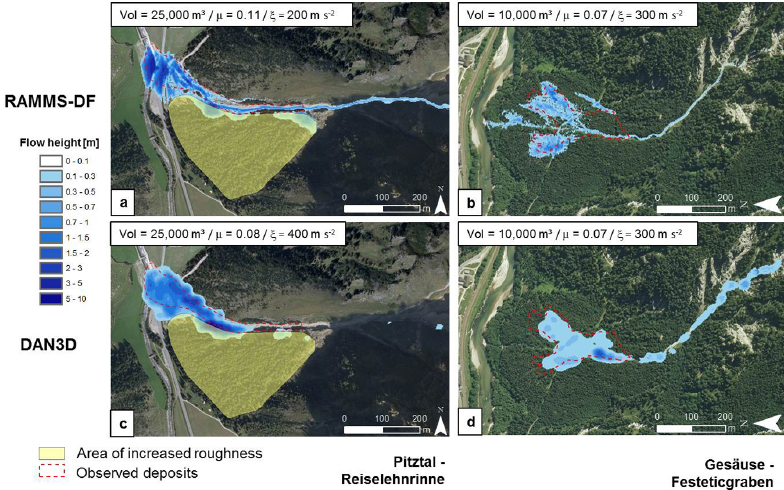
Figure 3. Best-fit simulations of RAMMS–DF and DAN3D for both study areas, the Reiselehnrinne ( a and c ) and the Festeticgraben ( b and d ; source aerial photo: National Park Gesäuse GmbH). Deposition heights are represented using blue color shading, for the results for the event in 2009 at the Reiselehnrinne Creek as well as for the event in 2006 at the Festeticgraben Creek. The red dashed lines represent the observed deposits. Areas of increased roughness are depicted in light yellow.